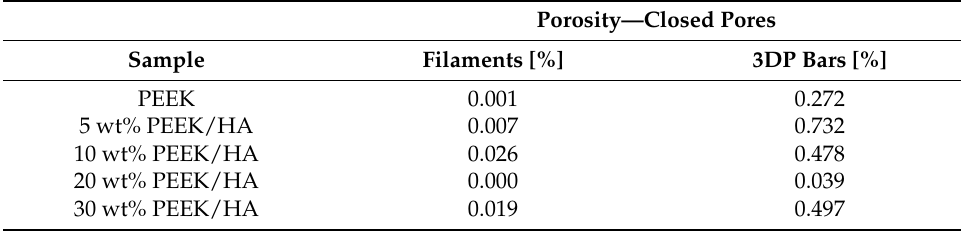
Figure A1. The CT Scans of 3DP rectangular specimens (pixel size 8 µ m). Table A1. Porosity calculated from CT